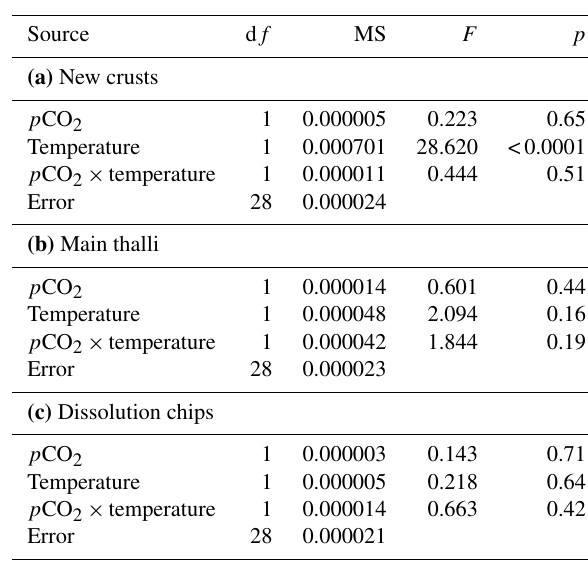
Table 2. ANOVA testing the effect of p CO 2 and temperature on skeletal mol% MgCO 3 in (a) new crusts, (b) main thalli, and